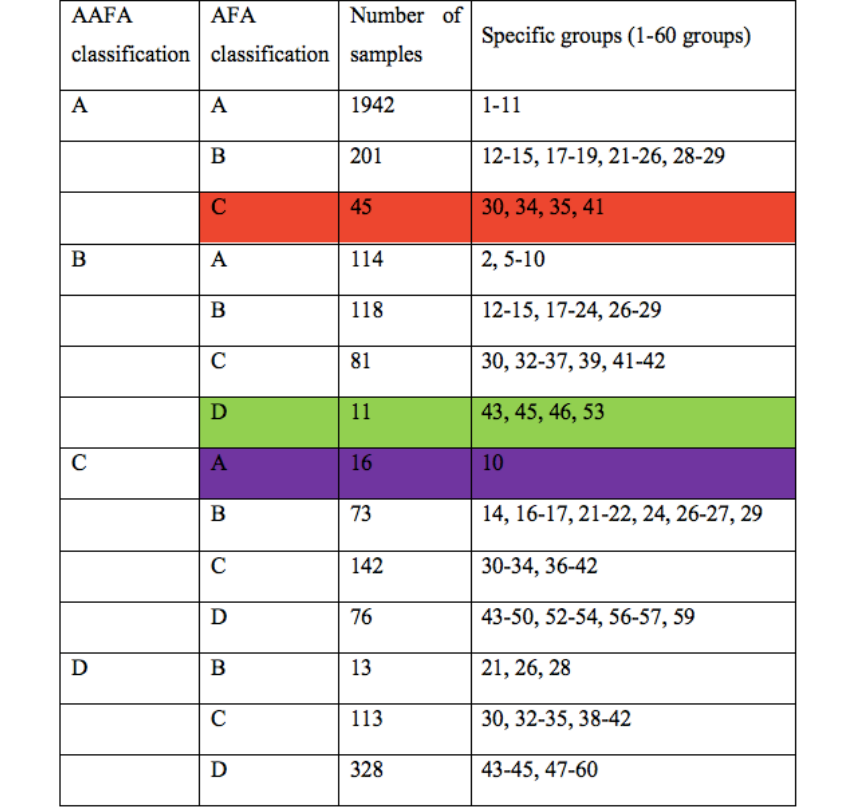
Figure 3. Specific differences between the AAFA and AFA models in A-D groups (tabular